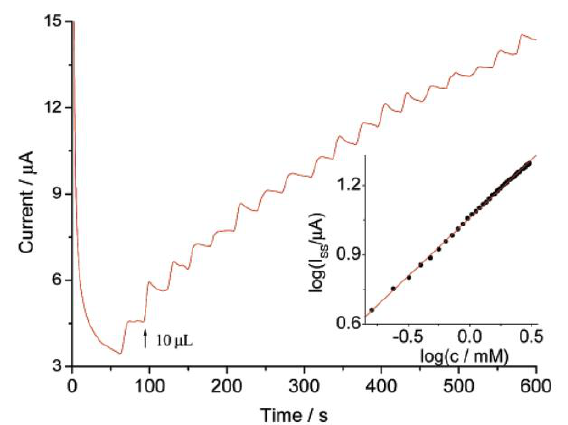
Figure 9. Amperometric response of the Hb/PUE/MWNT/PG electrode by successive addition of 10  L of 40 mM NaNO to 5 mL of air-free 0.2 M HAc-NaAc, pH 4.0, under 2 stirring at –0.7 V. Inset: Linear calibration curve. Reprinted from reference [46] with permission from The American Chemical